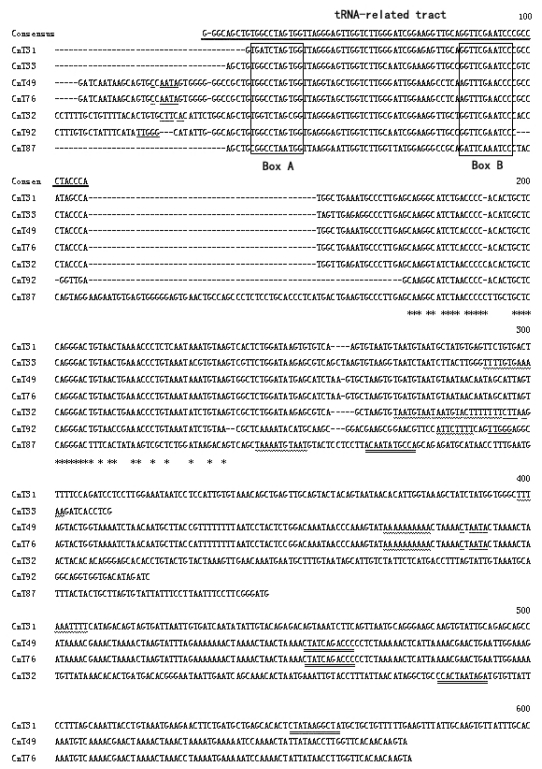
Cn-SINEs from Coilia nasus. The consensus sequences of the tRNA-related tract are shown on top and marked with thick bar. Boxes A and B are enclosed by solid lines. The target site duplications at each SINE locus are denoted by single underlines. A wavy line under nucleotides indicate poly(A) or AT-rich regions, and double lines under nucleotides show a reversed box A tract. Shaded nucleotides denote polymerase III transcription terminators. Asterisks indicate identical nucleotides; dashes denote gaps. GenBank accession numbers: JQ083280–JQ083286.